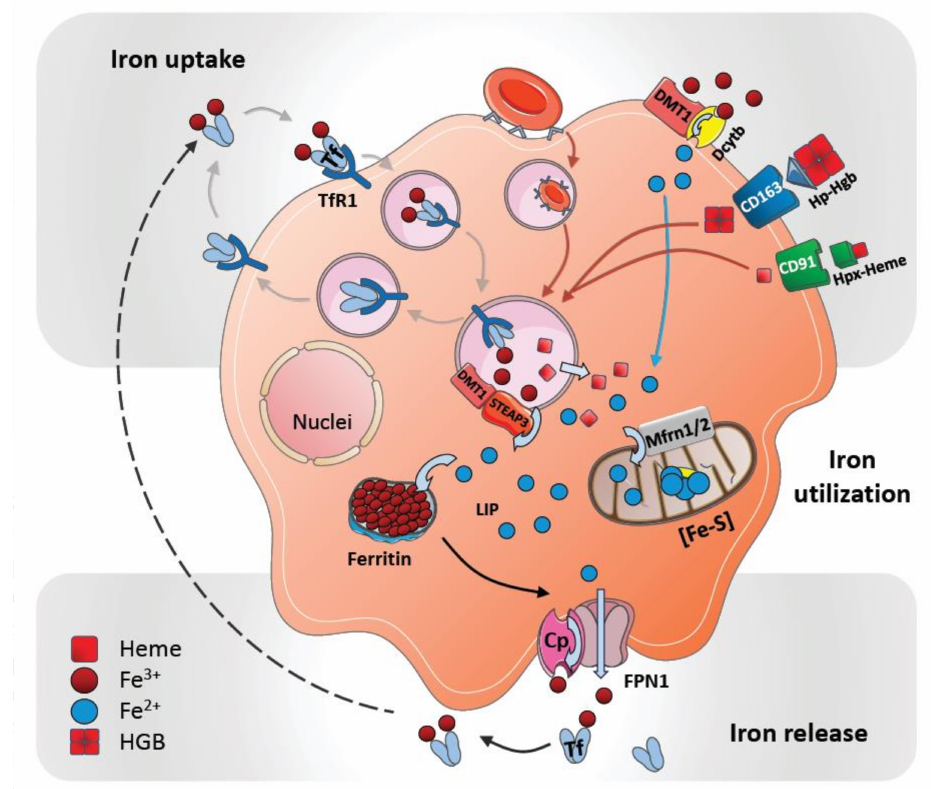
Figure 1. Iron metabolism by macrophages. General steps of iron uptake, acquisition, storage and release in the macrophage: In addition to iron extraction from red blood cells by erythrophagocytosis, macrophages express a variety of receptors to acquire iron from different sources. Transferrin-bound iron can be taken up by the transferrin receptor (TfR or CD71) and the complex is internalized by clathrin coated endocytosis followed by iron release at a low endosomal pH. Empty apo-transferrin and transferrin receptor complex are recycled again (grey arrows). Non-transferrin iron can be acquired directly via divalent metal transporter 1 (DMT-1) that is associated with duodenal cytochrome B (DcytB) (blue arrow). CD91 (LRP1) receptors scavenge hemopexin-bound heme (Hpx-Heme) iron, whereas haptoglobin- hemoglobin (Hp-Hgb) complex is taken up through CD163 receptor (red arrows). Iron transport across the endosomal membrane into the cytosol is accomplished through DMT1 after it is reduced by the endosomal reductase six-transmembrane epithelial antigen of the prostate 3 (STEAP3). The resulting intracellular free iron joins the labile iron pool (LIP), which is then either stored in ferritin or utilized in cellular processes for example in mitochondrial iron metabolism as ISC [Fe-S] after being transported through Mitoferrin 1/2 (Mfrn1/2). Iron can be exported through ferroportin 1 (FPN1) out of the cell, supported by the ferroxidase ceruloplasmin (Cp). Iron is then loaded to transferrin in order to be carried to the target